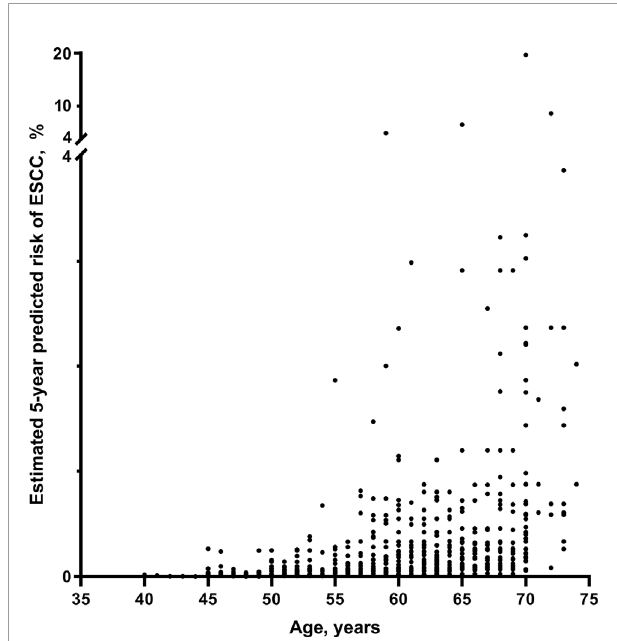
FIGURE 3 | The scatter plot of absolute 5-year risk (%) of ESCC in the studied Chinese population. ESCC, esophageal squamous cell